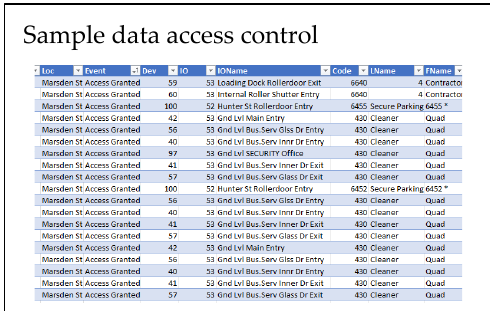
Figure 25. Access control data sample.